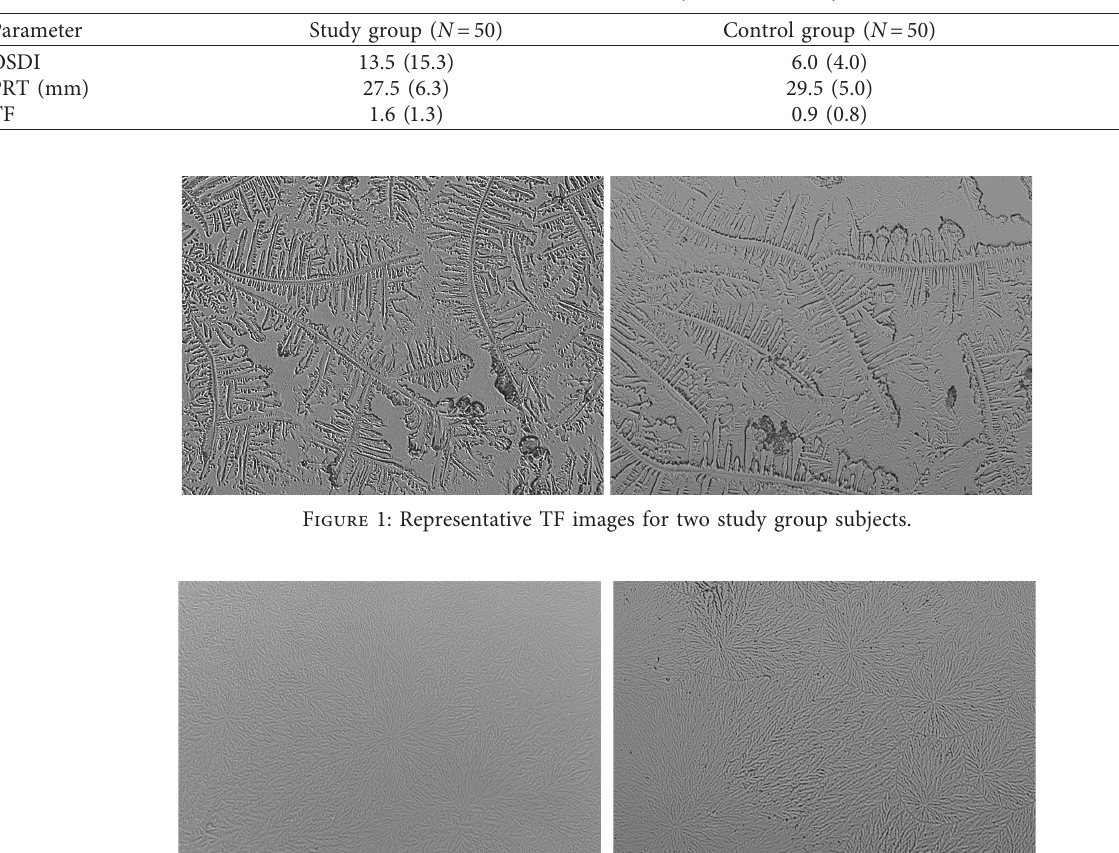
Table 1: Median (IQR) scores for the OSDI, PRT, and TF tests for subjects in the study ( N � 50) and control ( N � 50) groups.